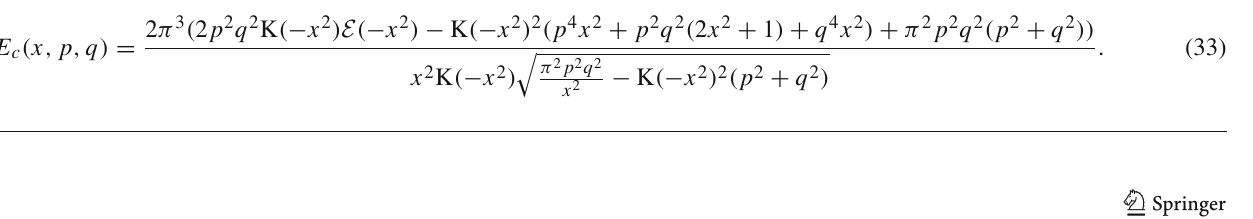
Fig. 3 Derivative of the energy, in terms of the basic dimensions of the Skyrmionic box, near its minimum value. The behaviour of the three ∂ E ∂ l i is the same irrespectively of p and q . The only thing that changes